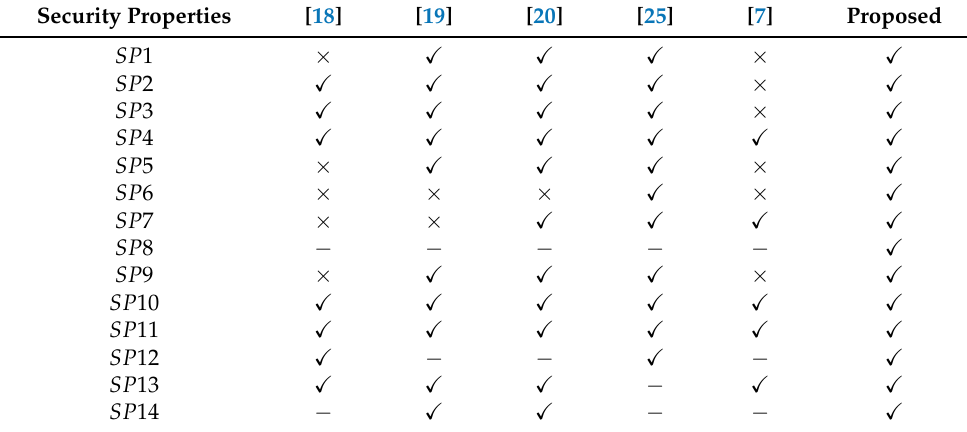
Table 3. Security and functionality features comparison.